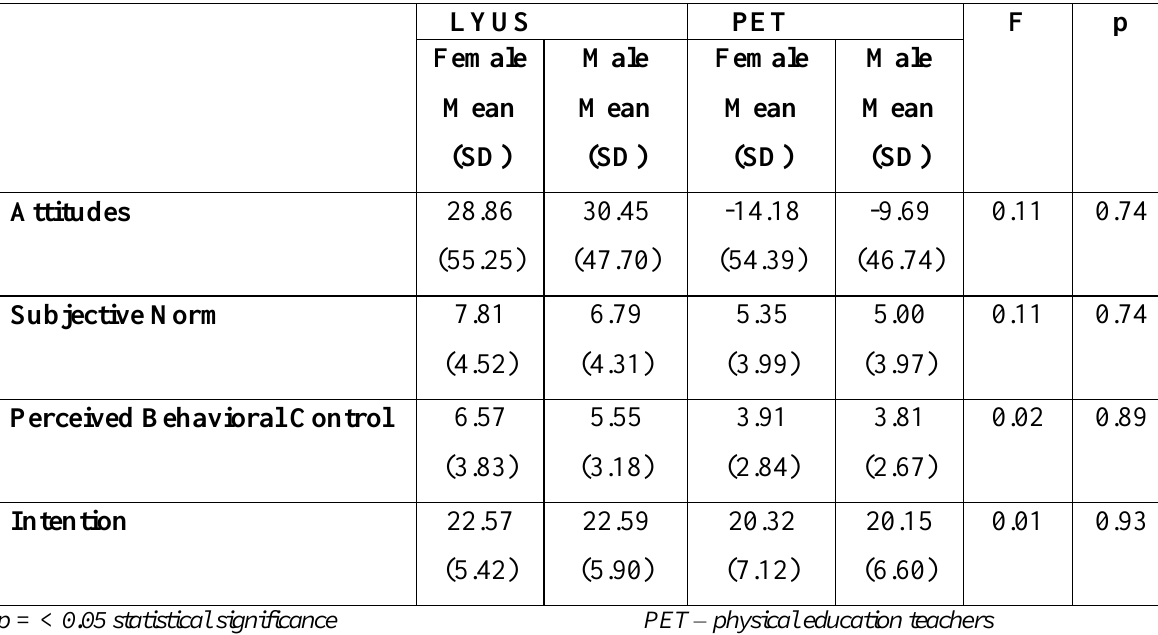
Table 4 Comparison of genders separate for LYUS and PET.